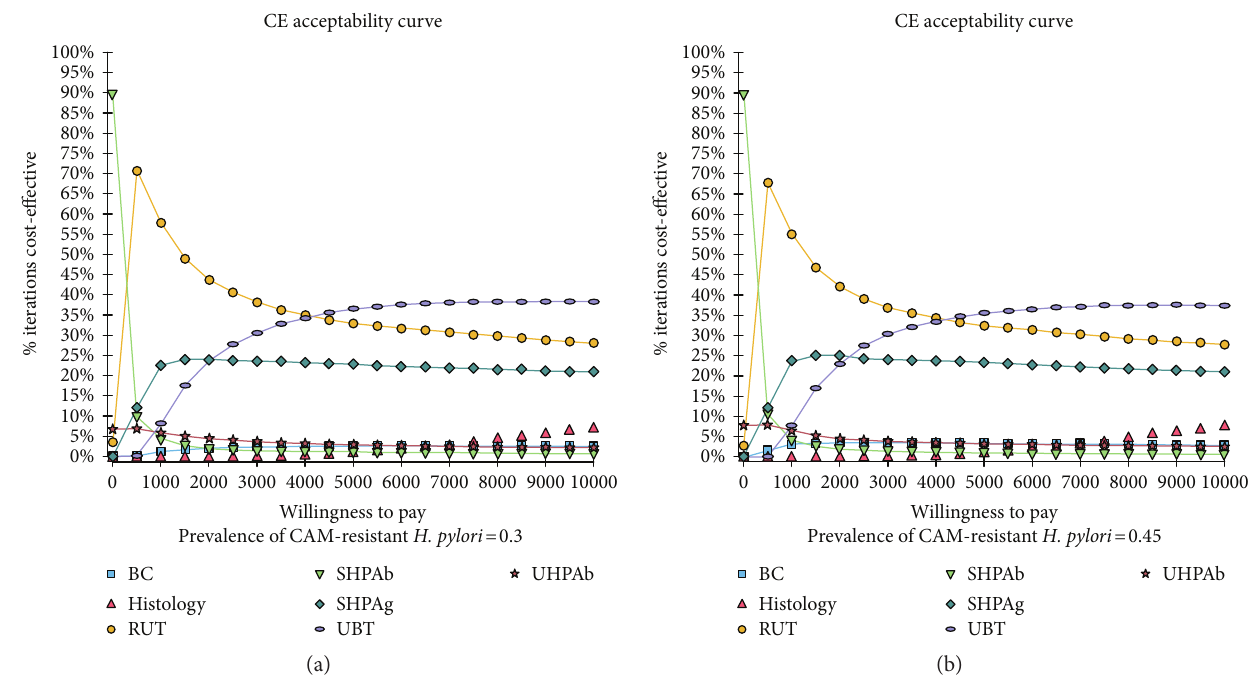
Figure 5: Acceptability curves using Monte Carlo simulation analysis with 0.3 (a) and 0.45 (b) of clarithromycin- (CAM-) resistant Helicobacter pylori (H. pylori) . Acceptability curve showed that serum H. pylori antibody or rapid urease test or urea breath test was an optimal diagnostic method depending on willingness to pay (WTP). Even if the prevalence of CAM-resistant H. pylori increased to 0.45, the probability that bacterial culture becomes an optimal method was low regardless of